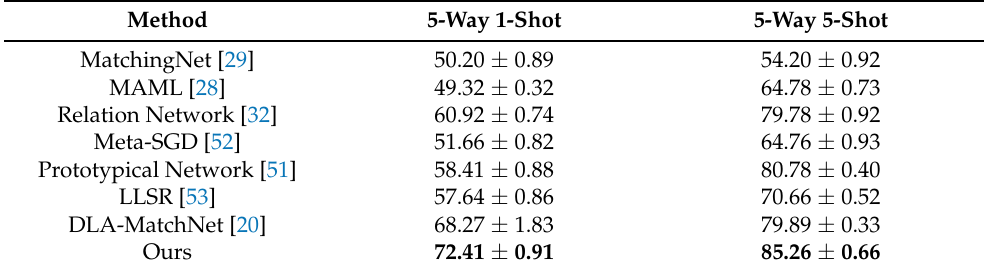
Table 3. Classification accuracy of 5-way 1-shot and 5-way 5-shot on the WHU-RS19 dataset.